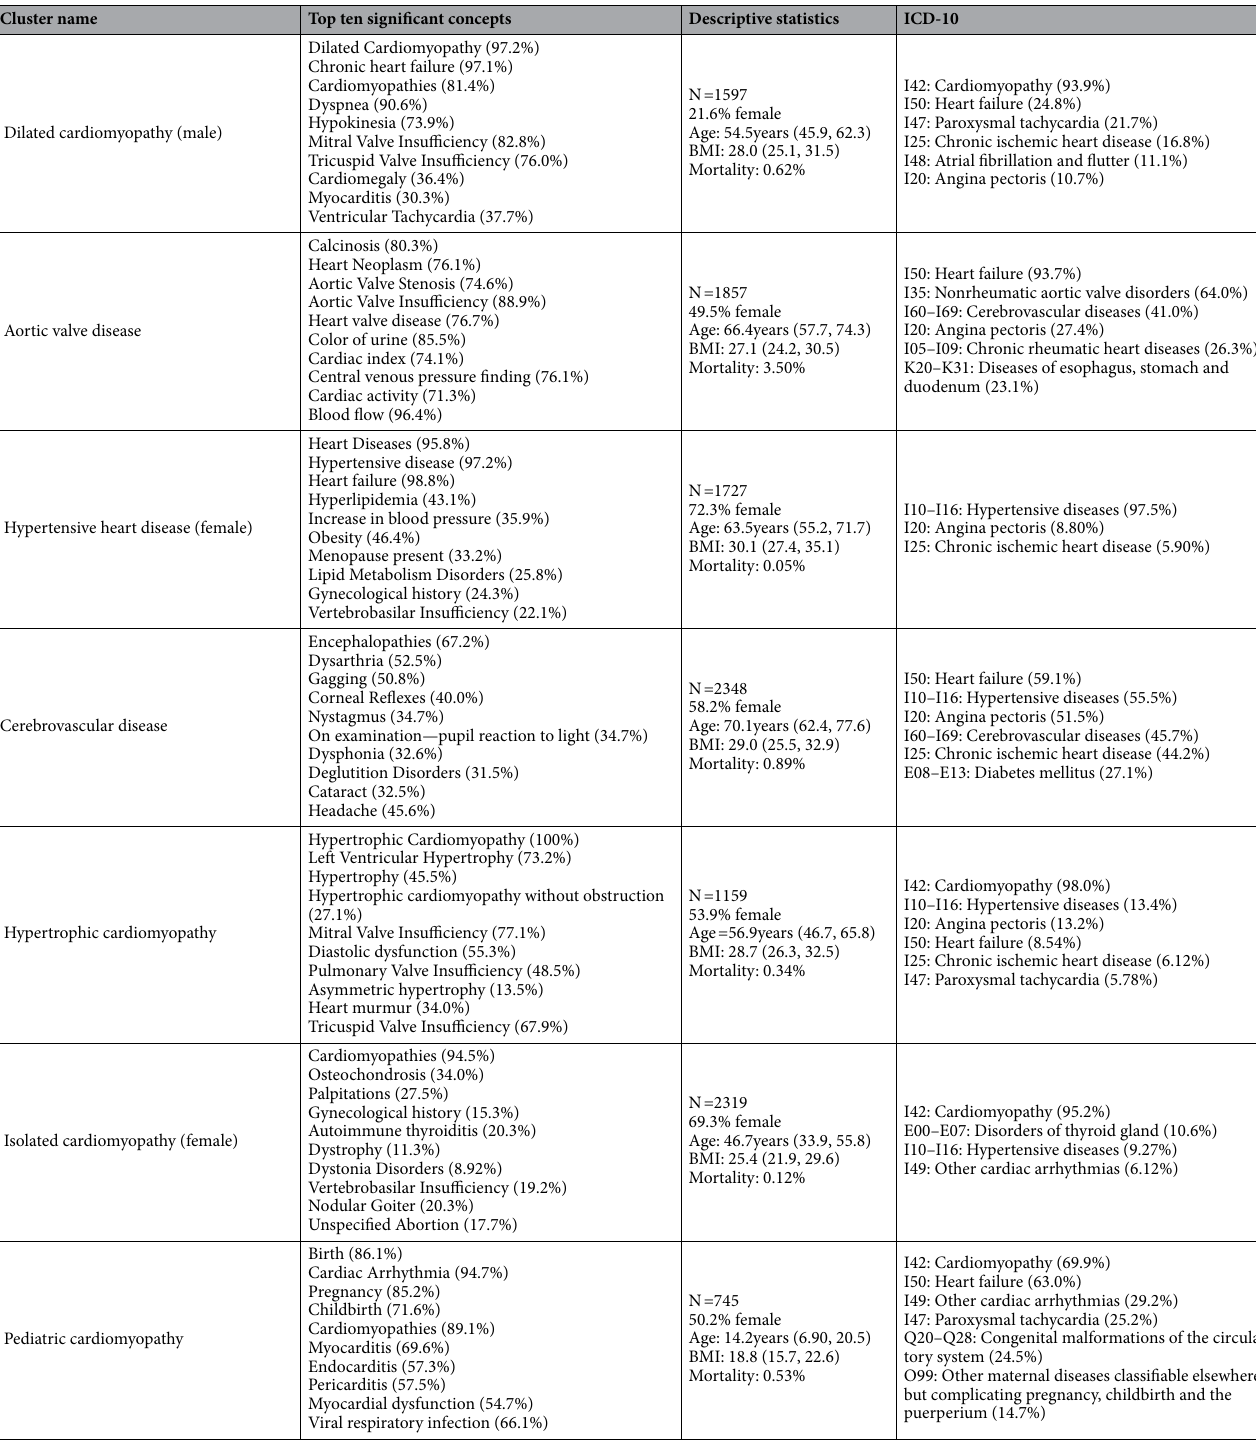
Table 2. Cluster characteristics for K = 15. Top ten most significant concepts for each phenotype, ranked by p value (smallest to largest). Significance was determined using a one-sided (greater) t-test with